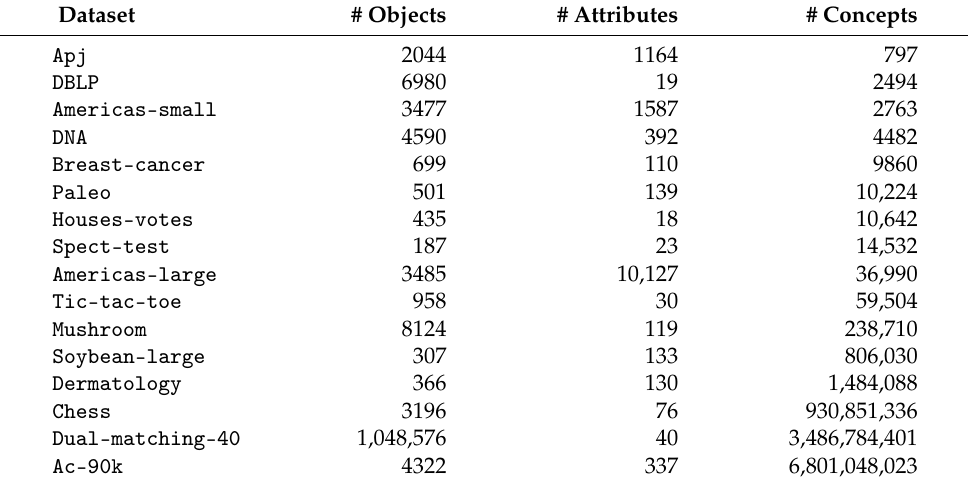
Table 7. The benchmark datasets ordered by the number of formal